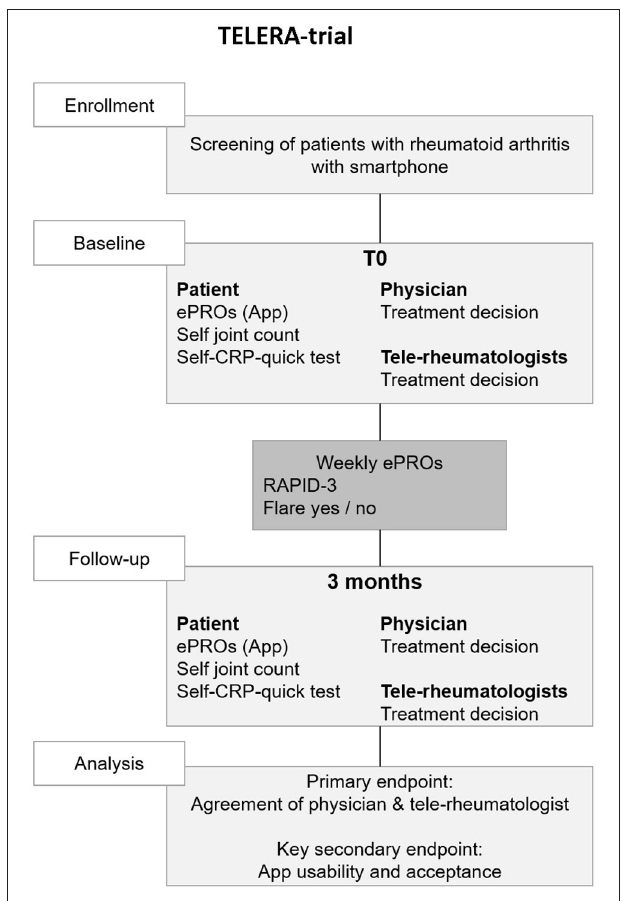
FIGURE 1 | Trial flow chart. CRP, c-reactive protein; ePRO, electronic patient reported outcomes; RAPID-3, routine assessment of patient index data 3.